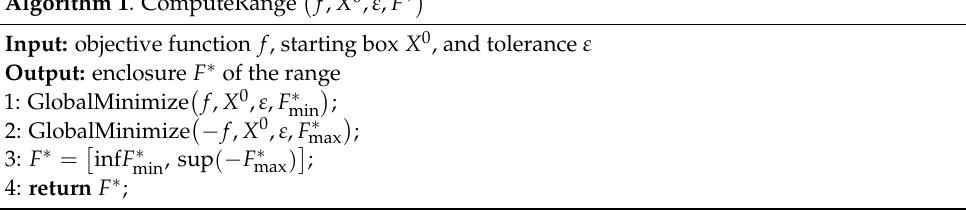
(cid:0) f , X 0 , ε , F ∗